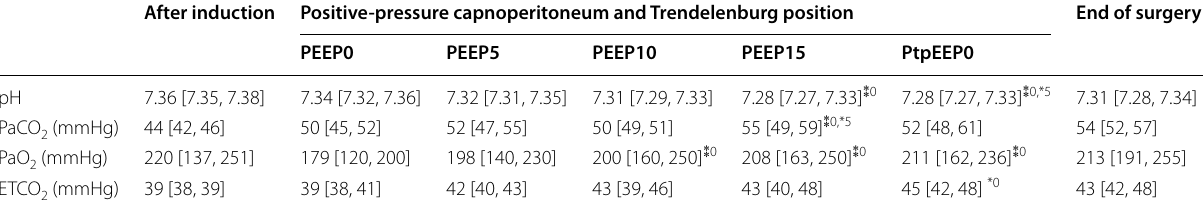
Data are presented as median values [interquartile range] PaCO 2 partial pressure of carbon dioxide, PEEP positive end-expiratory pressure *0 P < 0.05 vs. PEEP0; *5 P < 0.05 vs. PEEP5; ⁑ 0 P < 0.01 vs. PEEP0